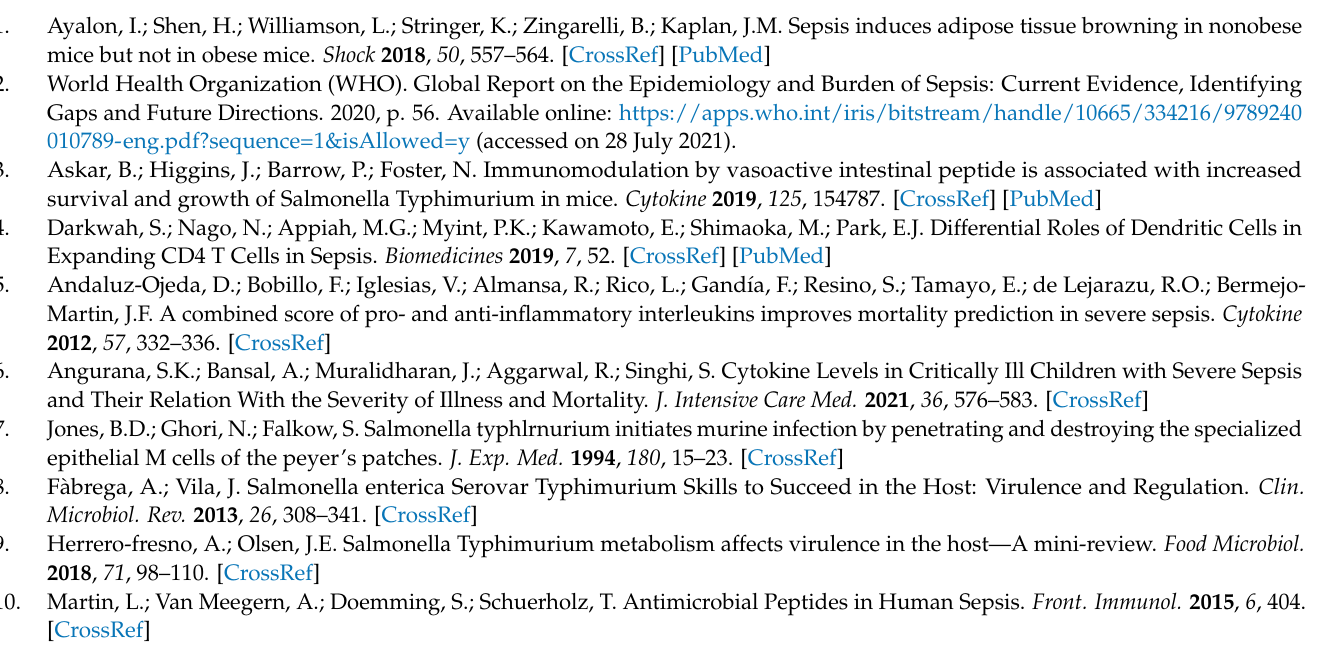
purification; Figure S4: Purification of MCP-1 by RP-HPLC. Figure S5: Mass spectrometry analysis of